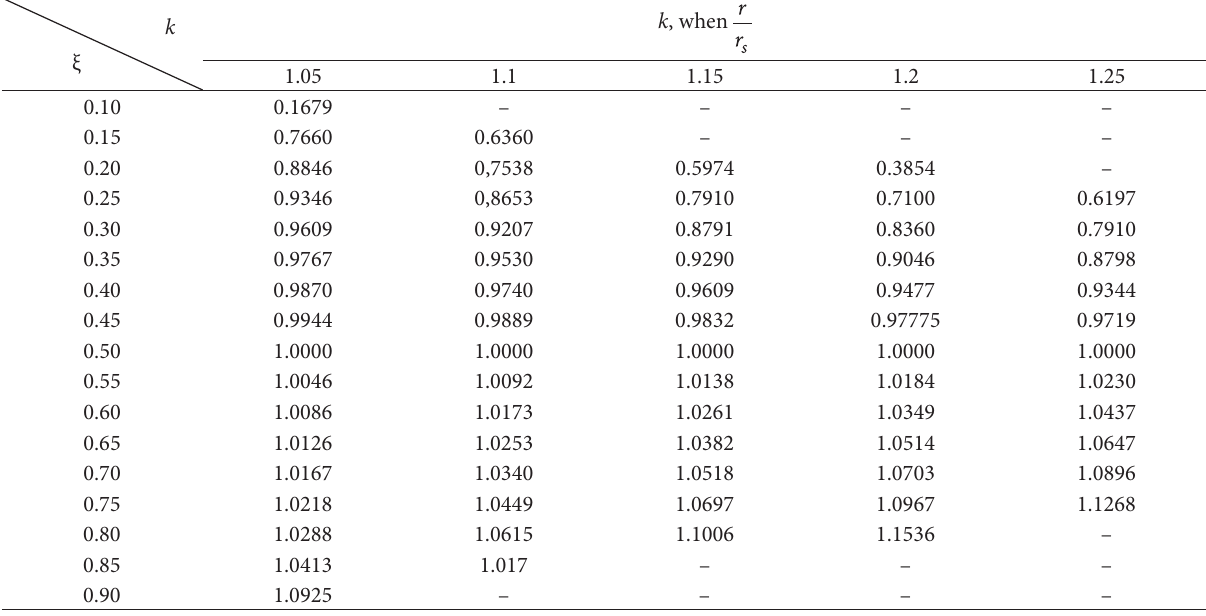
Table 1. The values of the coefficient k describing the relationship between ξ s and